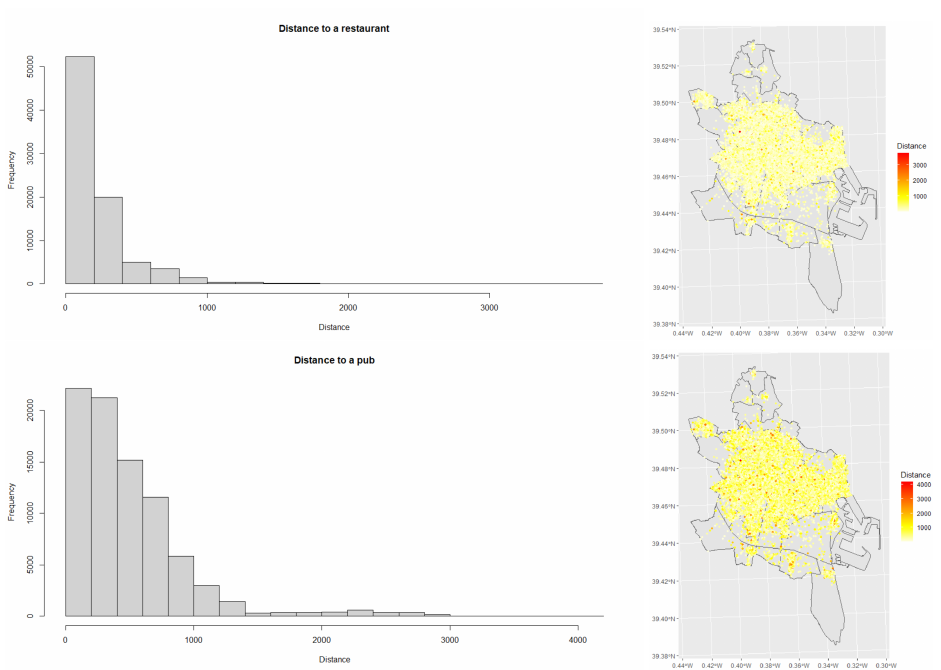
Figure 8. Histogram and corresponding point patterns coloured by their minimum distances to restaurants (top row) and to pubs (bottom row).